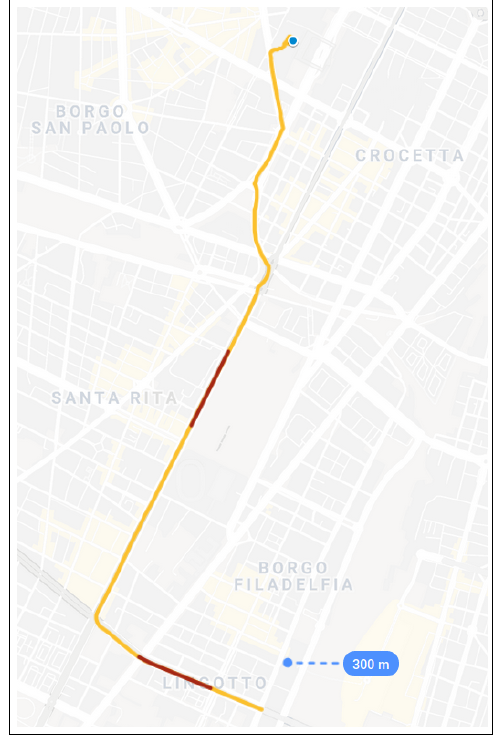
Figure 8. Kinematic trajectory in the streets of Turin. The yellow line depicts the Street stretch, and the red ones, the GNSS-denied stretches. The blue dot shows the starting point (image courtesy of Google